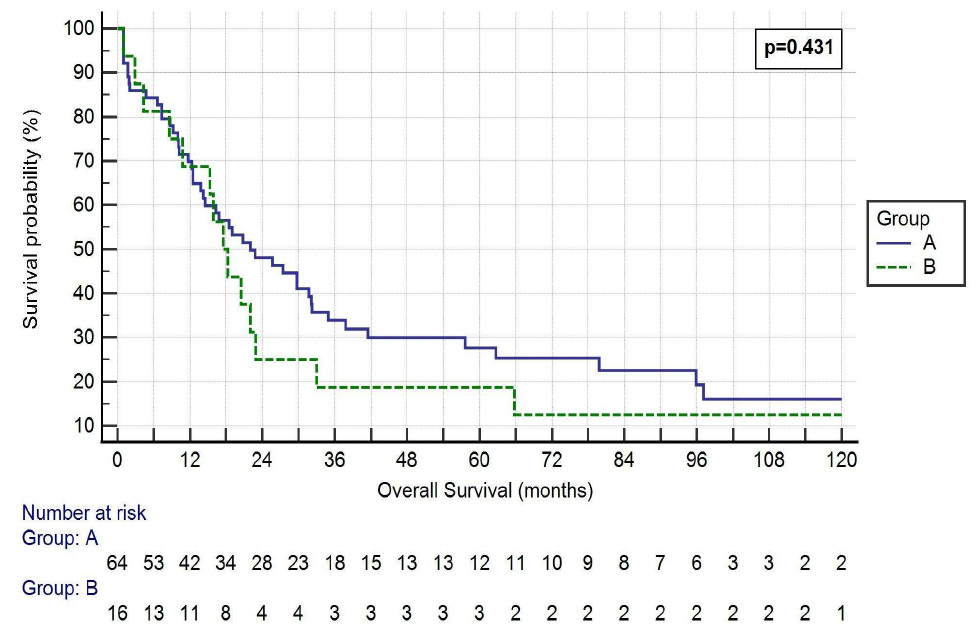
Figure 1. Kaplan–Meier curve of the OS of the two Groups. Log-rank p = 0.431. Group A: <50% SVC involvement and resection followed by direct suture or patch reconstruction; Group B: >50% SVC involvement and prosthesis reconstruction.